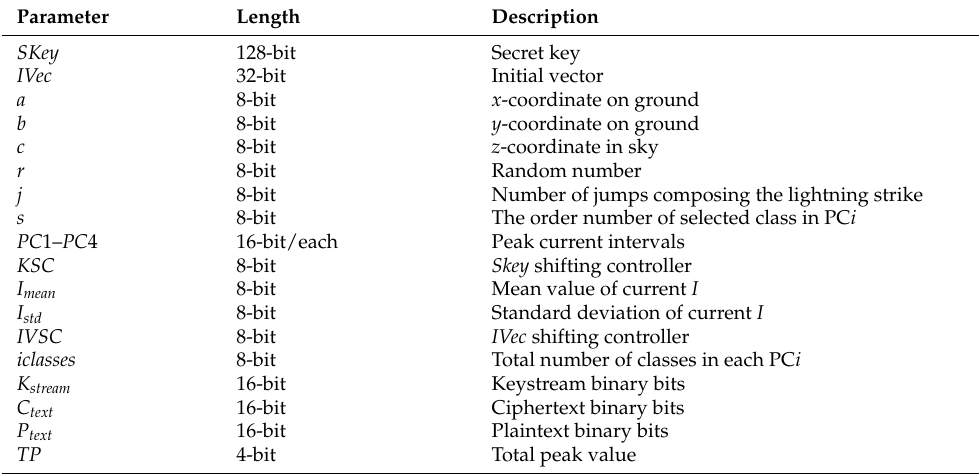
Table 3. Logarithmic normal distribution of lightning current parameters. Parameter